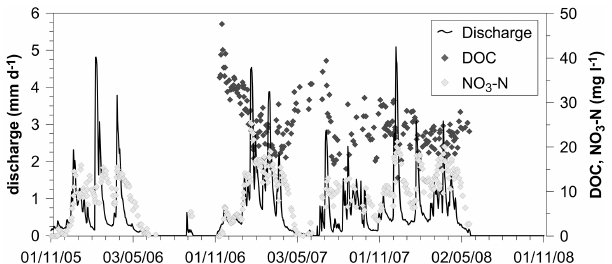
Figure 2. Discharge (mmd − 1 ) and concentrations (mgL − 1 ) of dis- solved organic carbon (DOC) and nitrate–nitrogen (NO 3 –N) in the